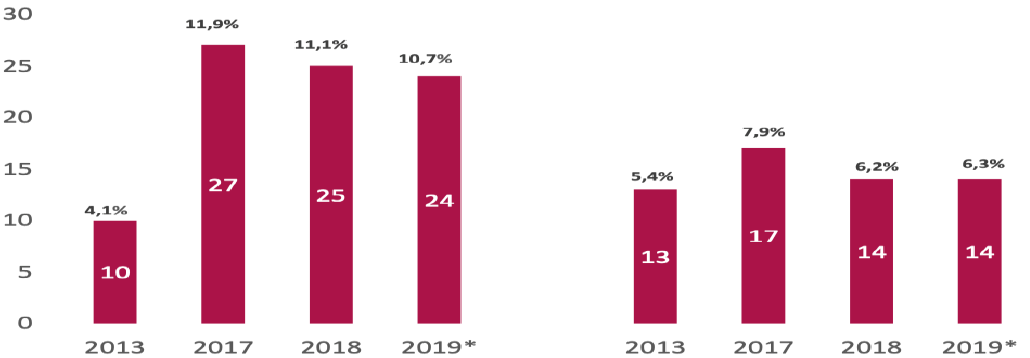
(Source: Inter-Institutional Observatory Report)